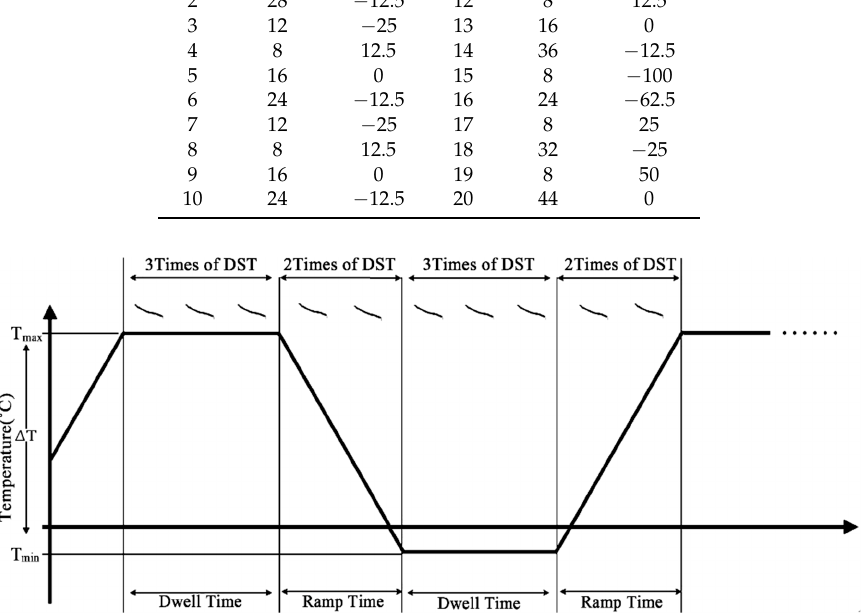
Figure 2. Test profiles of D 2 SADT.